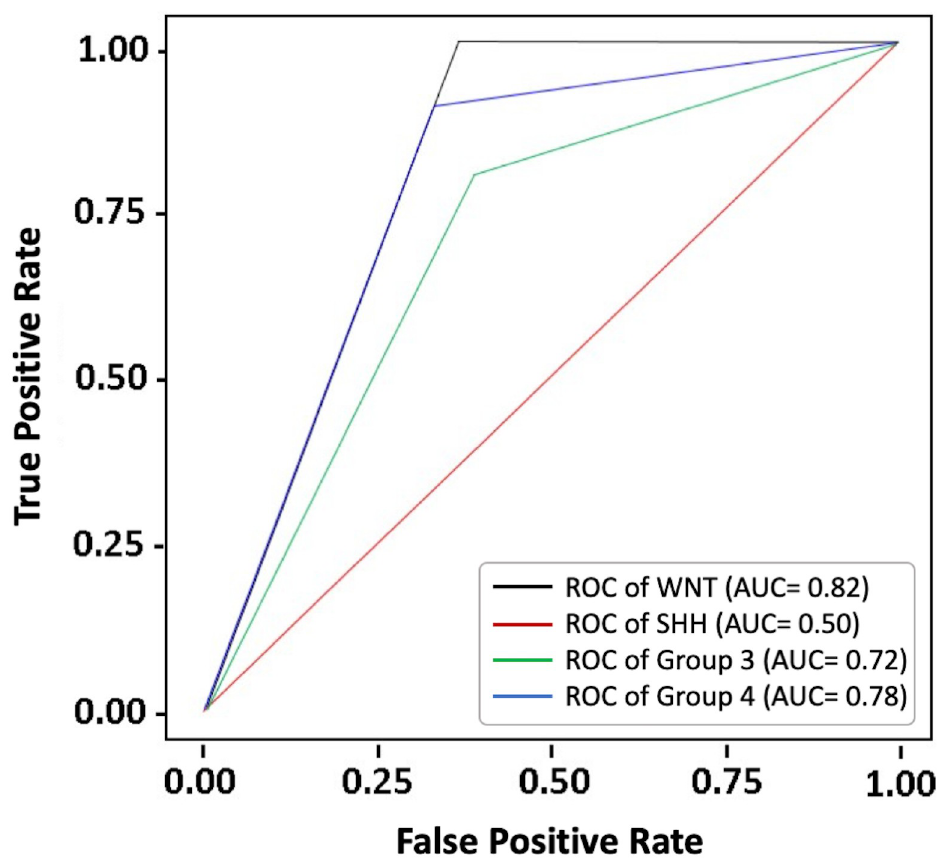
Fig 5. Receiver operating characteristic analysis of the preliminary prediction model. The prediction performance for predicting WNT, SHH, Group 3, and Group 4 MB was illustrated (area under the curve = 0.82, 0.50, 0.72, and 0.78,